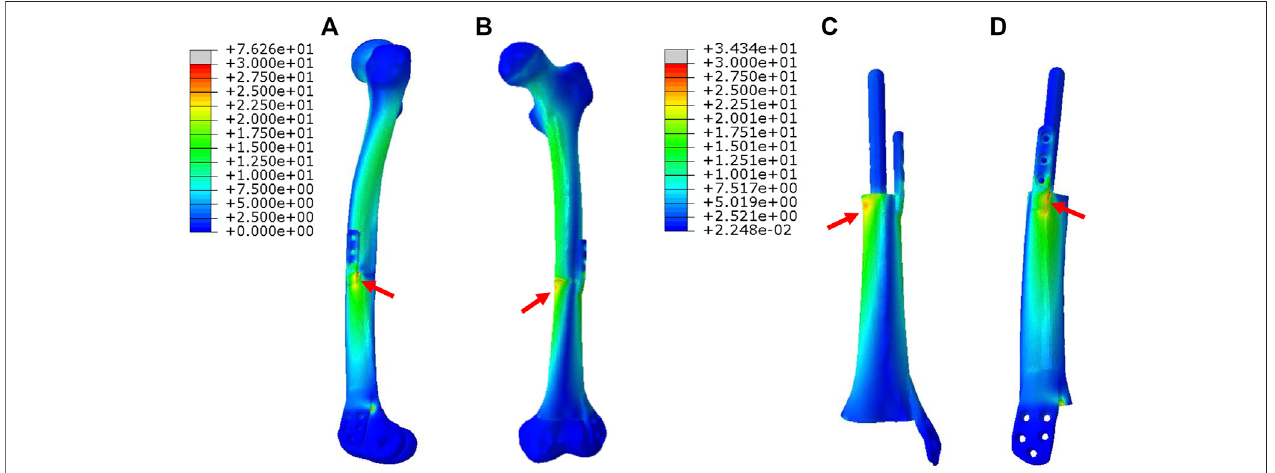
FIGURE 3 | Von Mises stress distribution in Mode I fi xation pattern, the red arrows direct the maximum stress concentration.